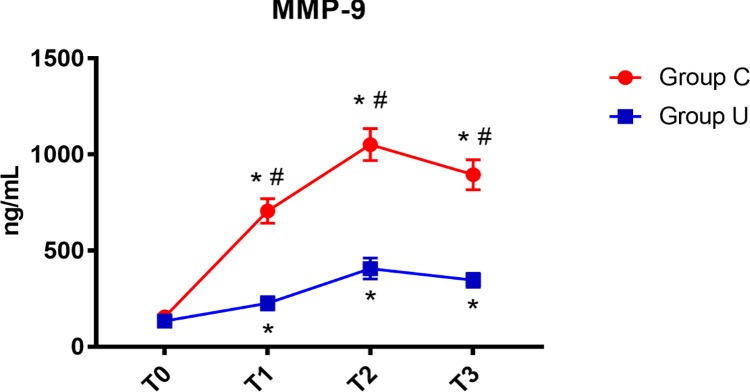
MMP-9 concentrations over time. MMP-9, matrix metalloprotease-9; Group C, the control group; Group U, the ulinastatin group. ∗P < 0.05 from T0 in group C and group U (statistically significant), #P < 0.05 from group U (statistically significant). T0 = before skin incision, T1 = the end of operation, and T2 and T3 = 24 and 72 h postoperative.